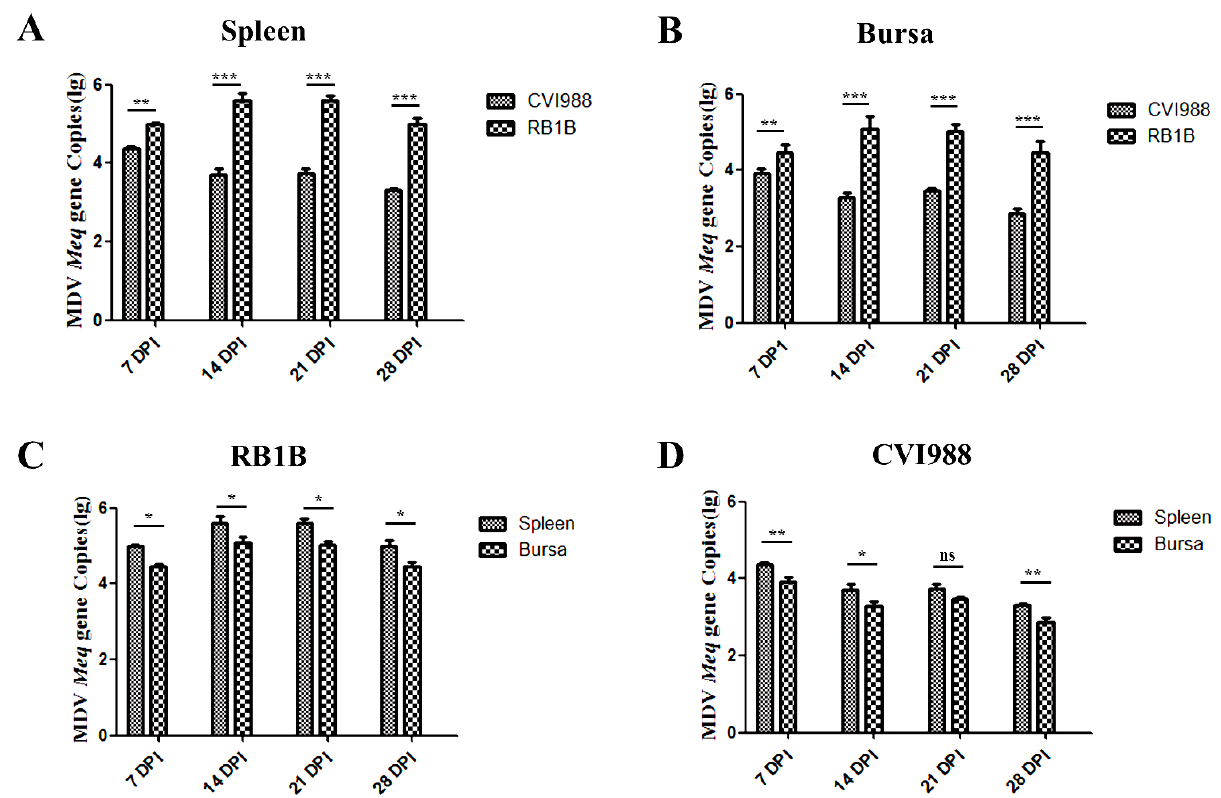
Figure 1. MDV/CVI988 and MDV/RB1B DNA replication in spleen and bursa. A : MDV/CVI988